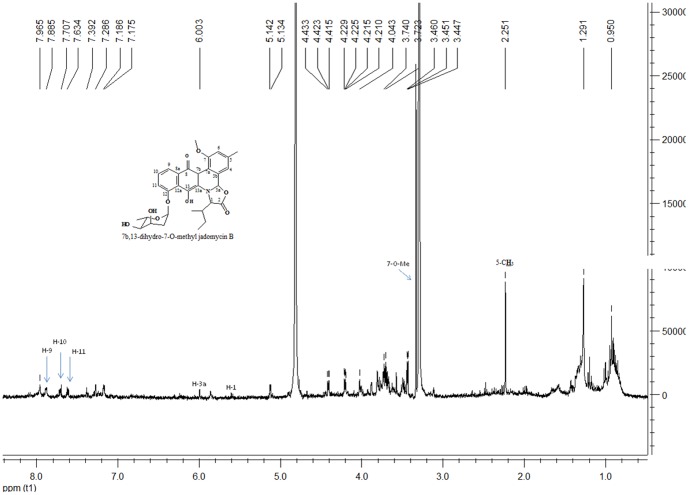

1H NMR data of selected ion at tR 4.18 min in TIC.